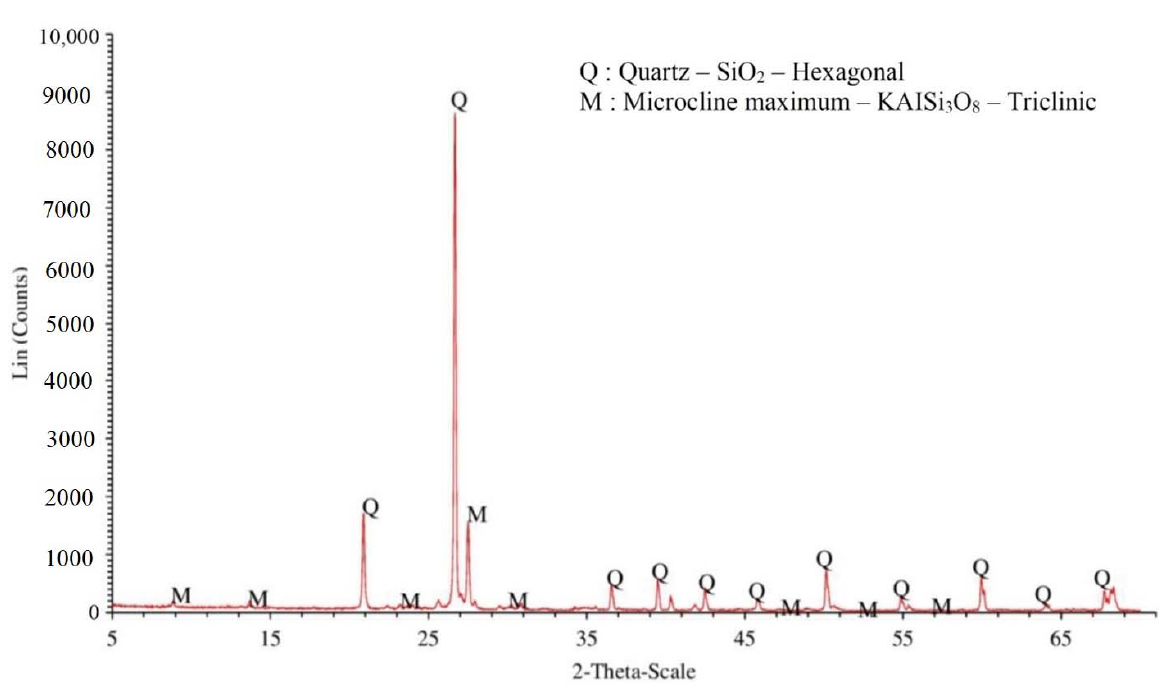
Figure 2. The qualitative results (XRD) of 5RS.